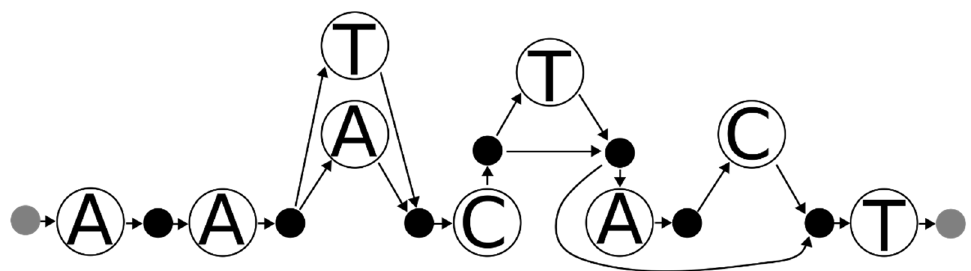
Figure 8. The graph from Figure 7 with two adjacent deletions (5 del, 6 del) added to it. Note that nothing is indicated about the relationship between the insertion and the deletion.